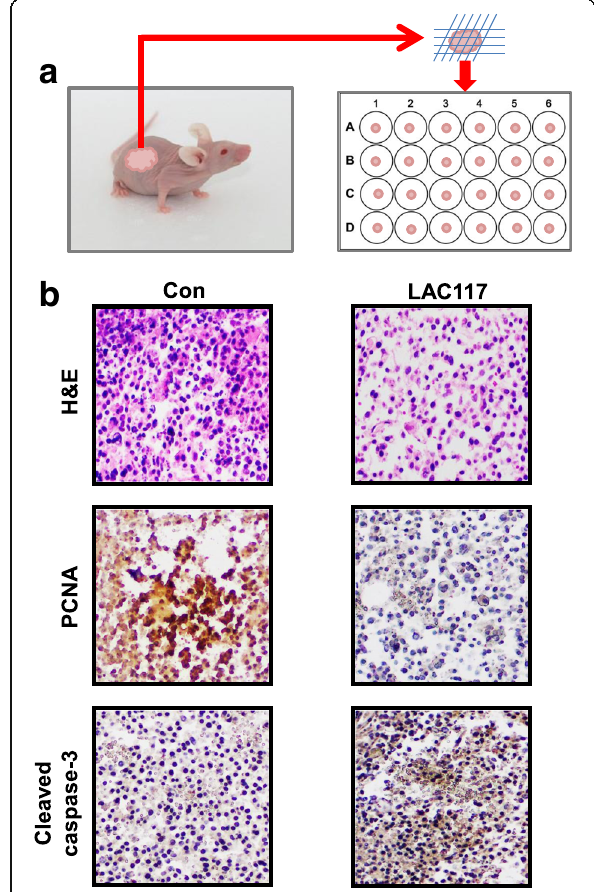
Fig. 5 Effect on HCC tumor ex vivo models. a Huh7 xenograft tumors from Balb/c nude mice ( n = 5) were harvested and cut into small pieces of ~ 2 mm, and each piece was maintained in culture media. Tumor spheroids cultured from the pieces were treated with LAC117 (100 μ g/mL) for 7 days. b Tumor spheroids were excised and processed for immunostaining for PCNA, cleaved caspase-3, and H&E staining. The results were observed by microscopy at ;×400